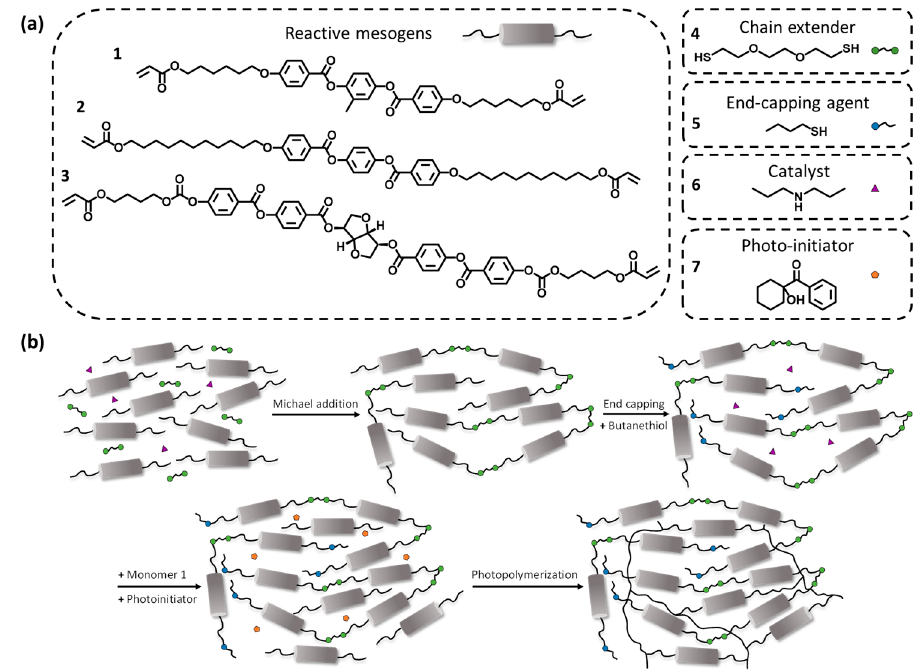
Figure 1. ( a ) Structures of the components used for preparing the oligomers and semi-interpenetrating networks. ( b ) Schematic representation of the preparation of the oligomers and the semi-interpenetrating networks.